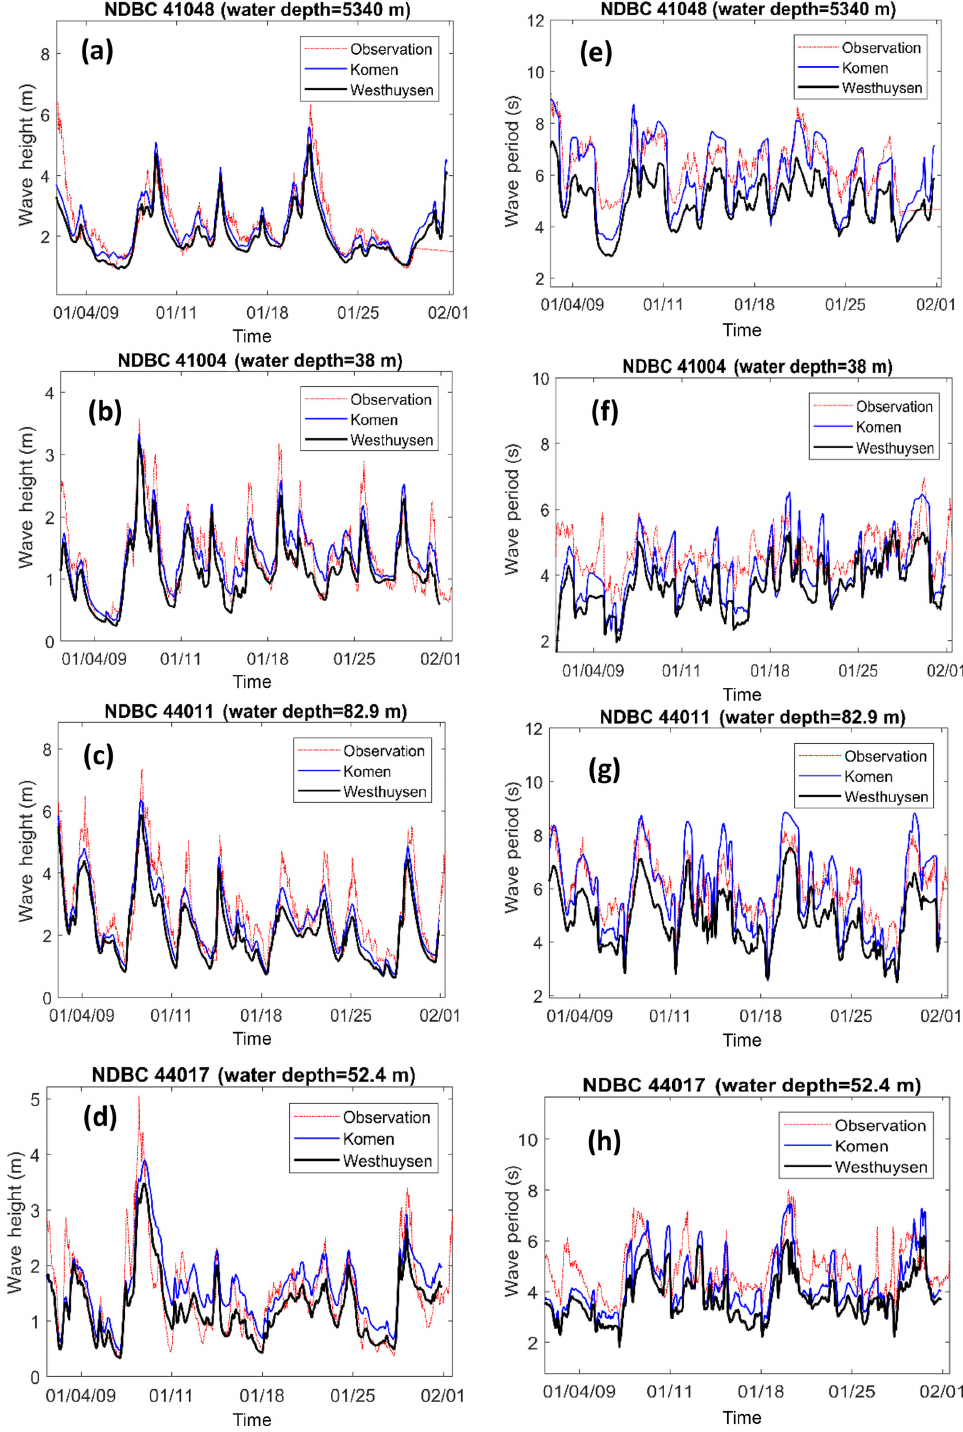
Figure 6. (a–d) Time series of simulated wave heights and (e–h) simulated mean wave periods, using Komen (blue lines) and Westhuysen (black lines) whitecapping formulas compared to measurements at the four NDBC buoys (dashed red